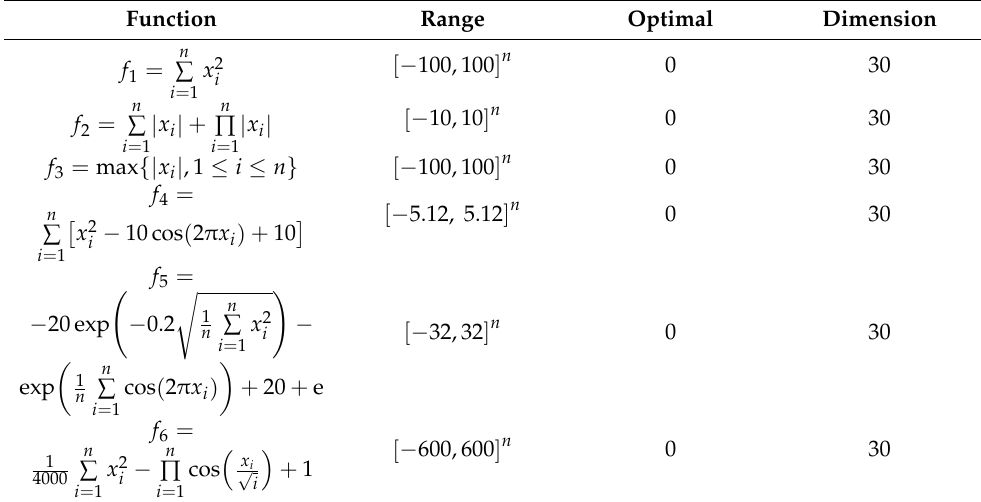
Table 1. Benchmark functions: f 1 – f 3 are unimodal functions and f 4 – f 6 are multimodal functions. Function Range Optimal